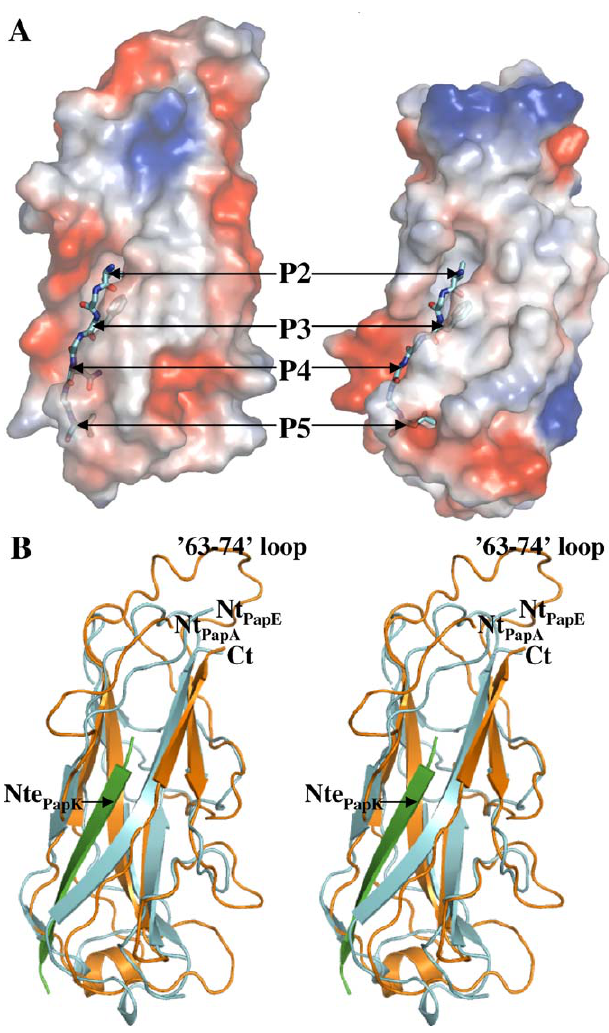
Figure 5. Comparison of dsePapA (in PapD/(PapA Ntd1_G15N_T101L ) 2 ) and dsePapE (in PapE/K Nte ) (A) Surface representation of dsePapA (left) and dsePapE (right). Residues of PapK Nte as well as dscPapA Nte are shown in stick representation color-coded in red, dark blue, and cyan for oxygen, nitrogen, and carbon atoms, respectively. For clarity, only side chains of the residues interacting in the P2 to P5 pockets are shown. (B) Secondary structure representation of dsePapA (orange) and dsePapE (cyan) bound to K Nte (green). The structures are in stereo ribbon representation. The N- and C-termini of both molecules are indicated, as well as the ‘‘ 63–74 ’’ loop in dsePapA.